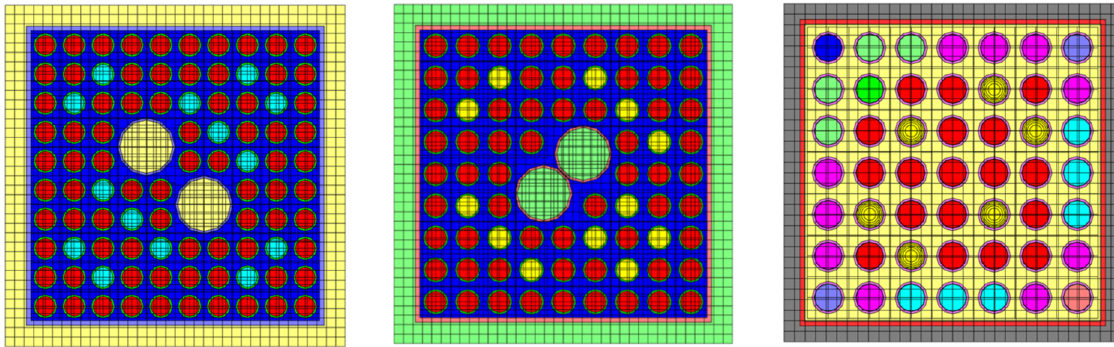
Fig. 3. GE BWR 10 (cid:3) 10-8 @ 14 Gd fuel pins (left); GE BWR FA 9 (cid:3) 9-7 @ 12 Gd fuel pins (center); GE BWR 7 (cid:3) 7 @ 6 Gd fuel pins (right). Table 5. Contributions to overall uncertainty in criticality eigenvalue for the GE10 (cid:3) 10-8 FA. Covariance matrix Contributions to uncertainty Nuclide-reaction